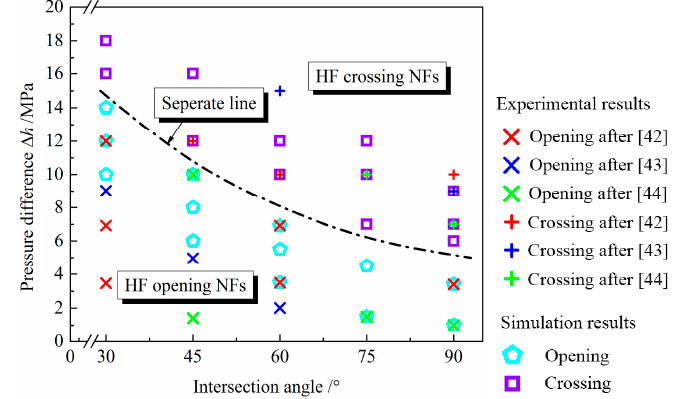
Figure 15. Comparison between the interactive behavior in the physical experiment and numerical simulation. Table 2. Micro-properties used in smooth joint (SJ) contact for simulated specimens after calibration.